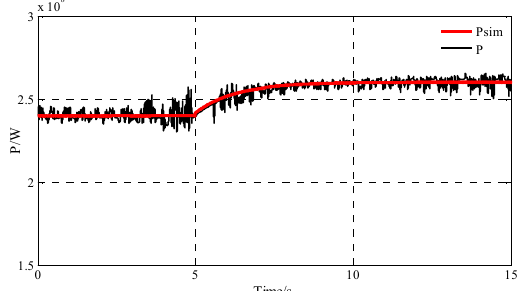
Figure 21. Comparison of active power waveform before and after equivalent during stable operation stage.